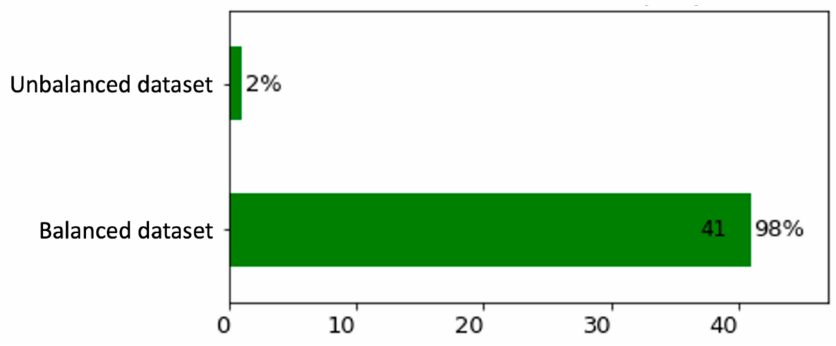
Figure 20. Breakdown of amount of data for each